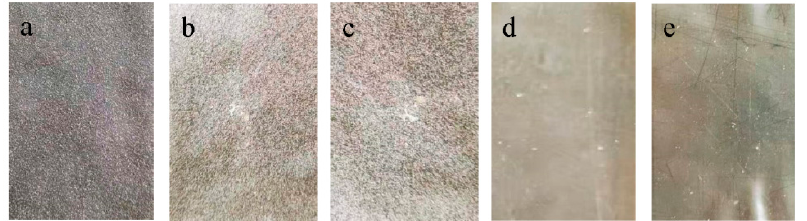
Figure 2. Films of SPI and fractioned products: ( a ) SPI, ( b ) lower protein, ( c ) upper protein, ( d ) 11S globulin, and ( e ) 7S globulin. Table 1. Yields and contact angles of the samples.